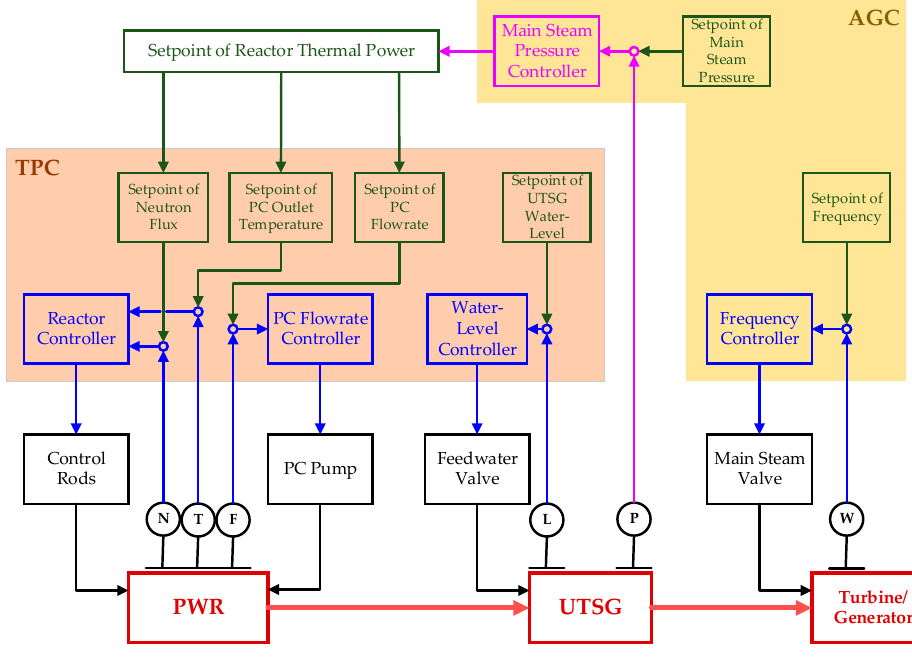
Figure 4. Control scheme diagram of PWR power plant.